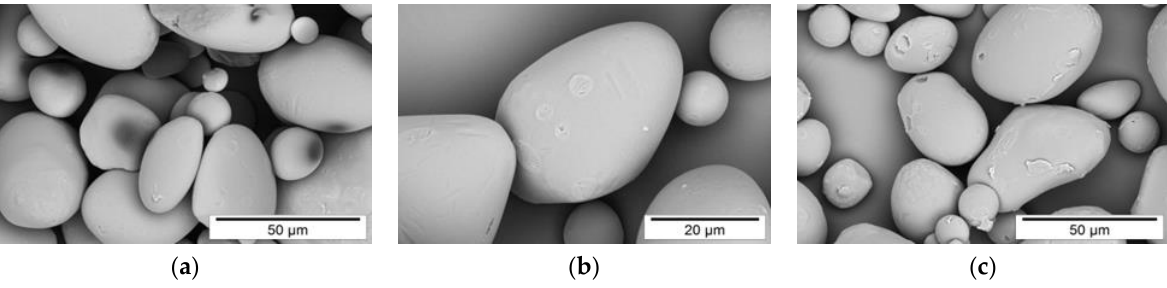
Figure 3. Scanning electron microscope (SEM) images of starches oxidised with ( a ) NaOCl (pH 8.2, 35 °C and 5.5 mol% -OCl), ( b ) DMH (pH 8.2, 35 °C and 8.5 mol% -OCl) and ( c ) DMH (pH 8.2, 45 °C and with 17 mol% -OCl).